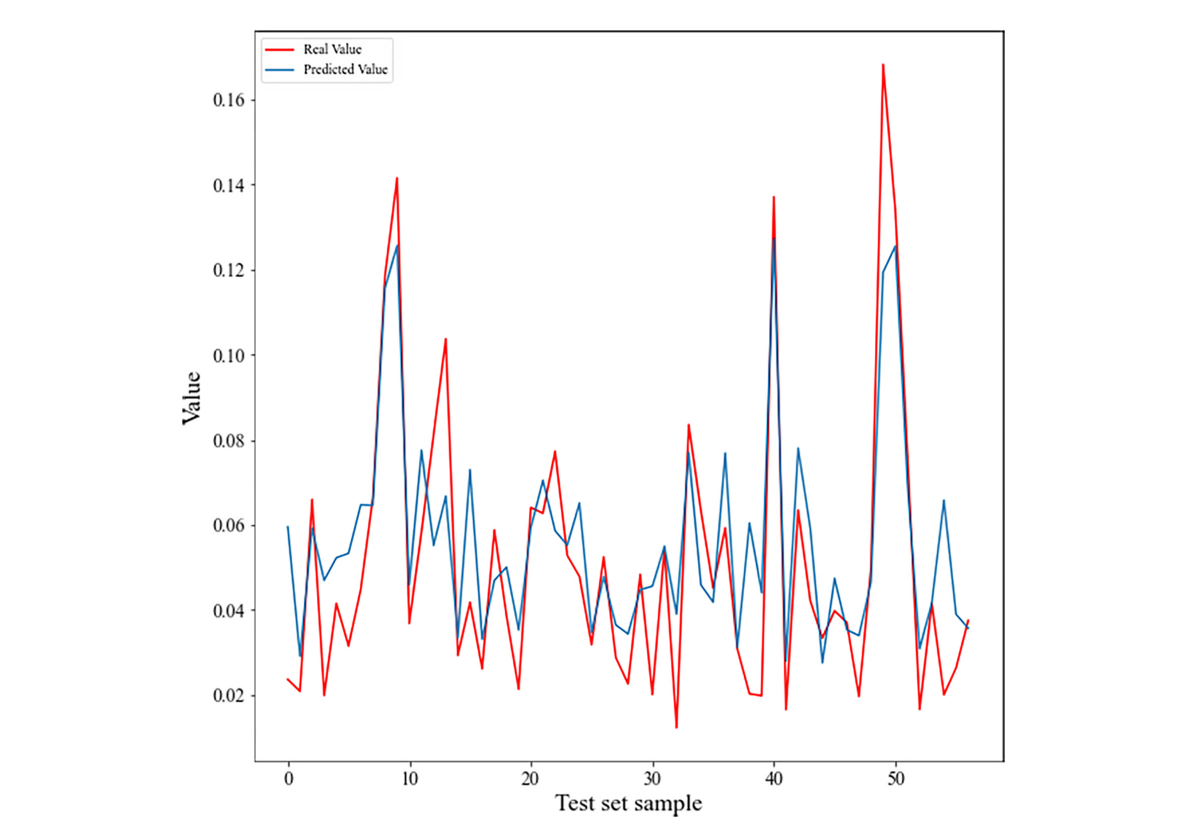
FIGURE6 Line chart showing F ST vs. predicted genetic differentiation value for the F ST test set. Pearson’s correlation coefficient is 0.87 ( p < 2.2e − 16